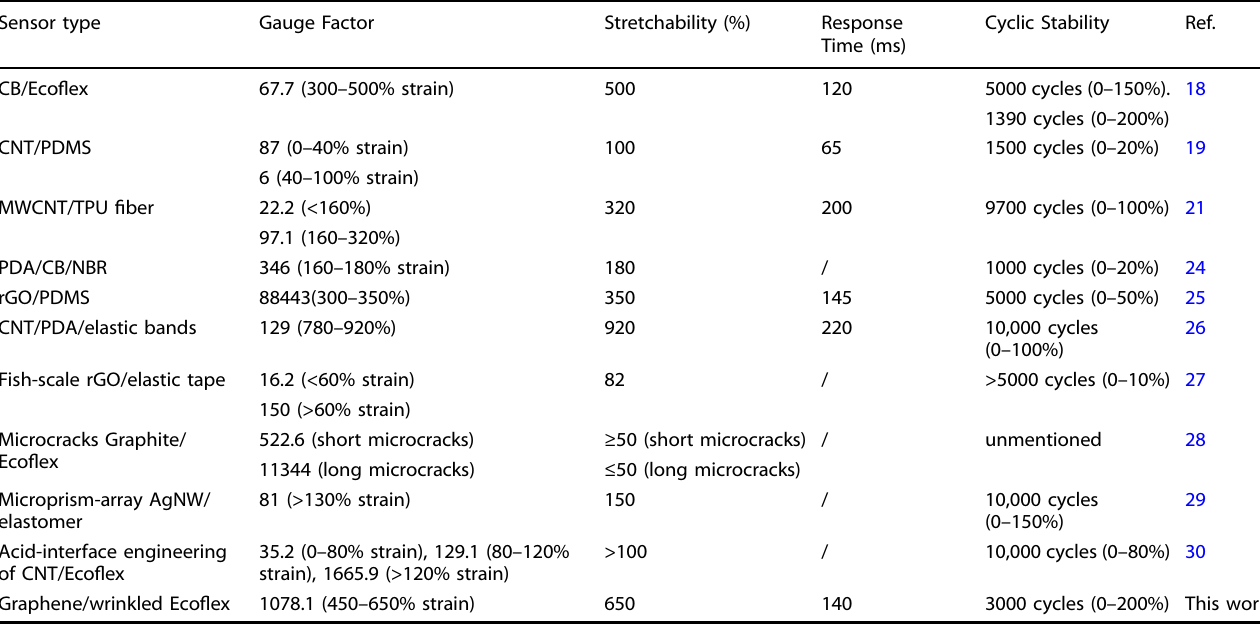
Table 2. Comparisons of Device Performance of Resistance-Type Strain